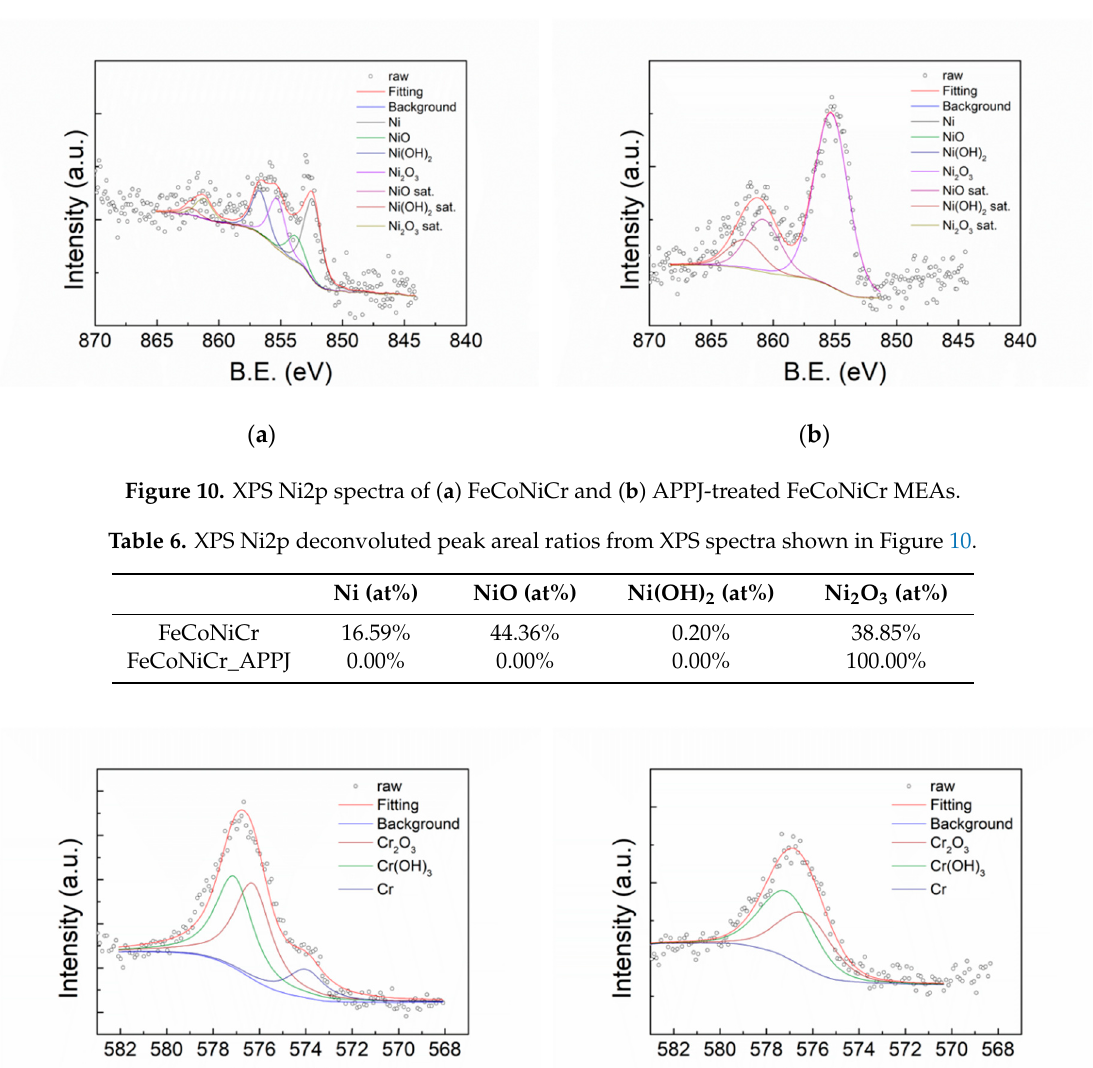
( b ) Figure 9. XPS Co2p spectra of ( a ) FeCoNiCr and ( b ) APPJ-treated FeCoNiCr MEAs. Table 5. XPS Co2p deconvoluted peak areal ratios from XPS spectra shown in Figure 9.